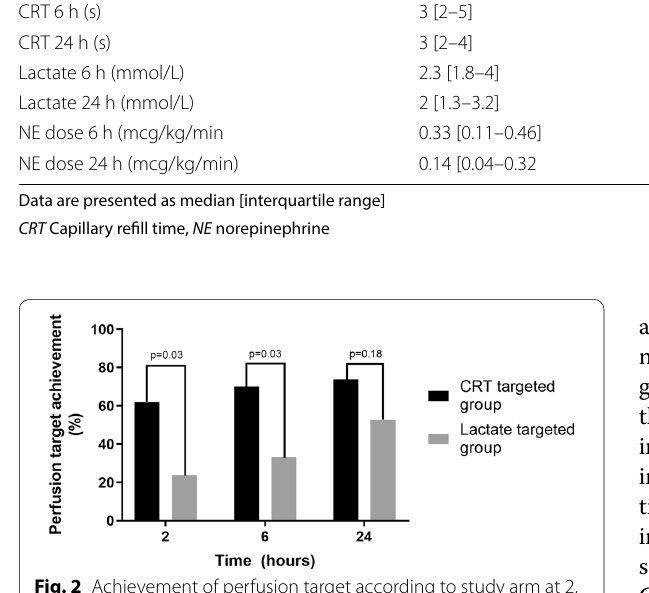
Table 3 Multimodal perfusion comparison between both study groups at 6 h